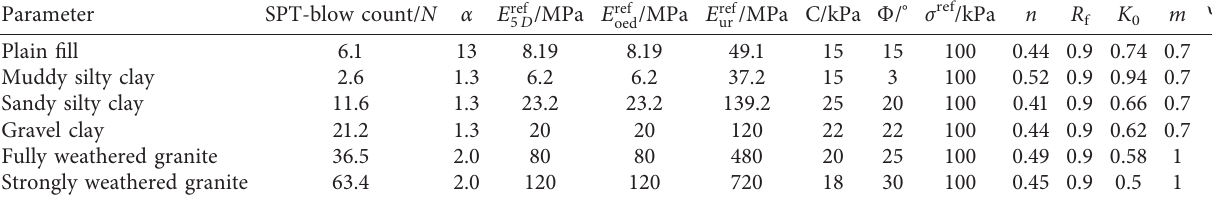
Figure 8: FEM mesh of the calculation model. (a) Foundation pit grid. (b) Supporting structure grid. Table 4: Geotechnical parameters used in the study.